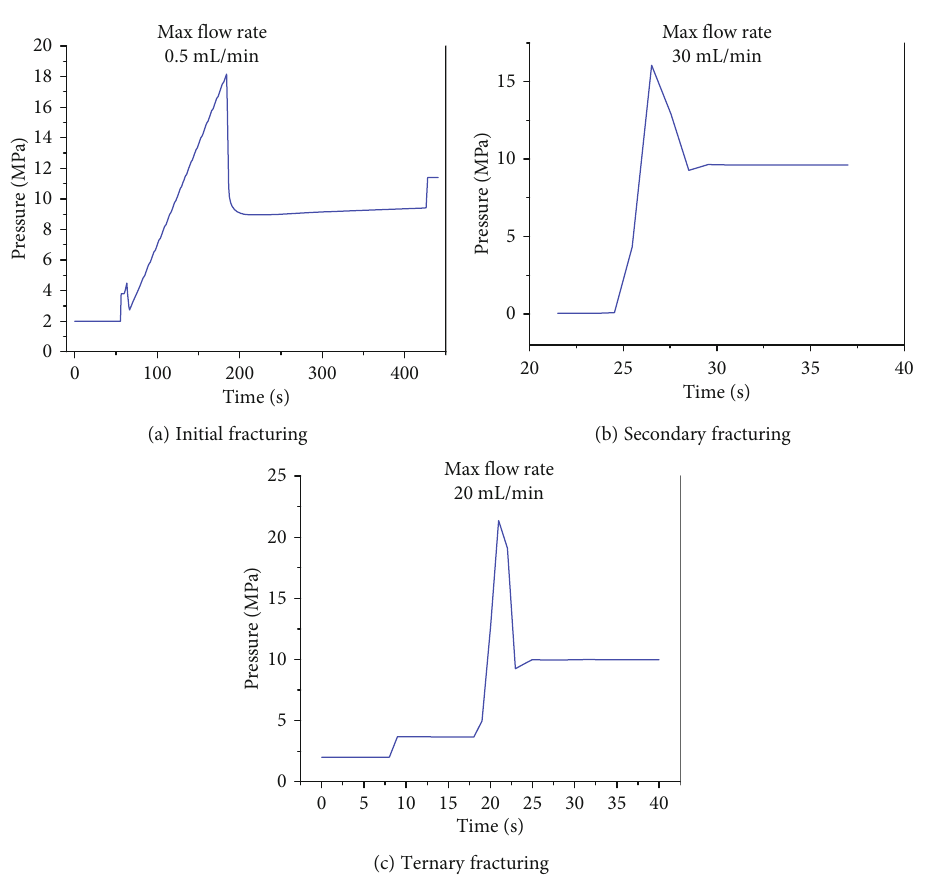
Figure 3: Pressure versus time from multiple-stage fracturing of sample